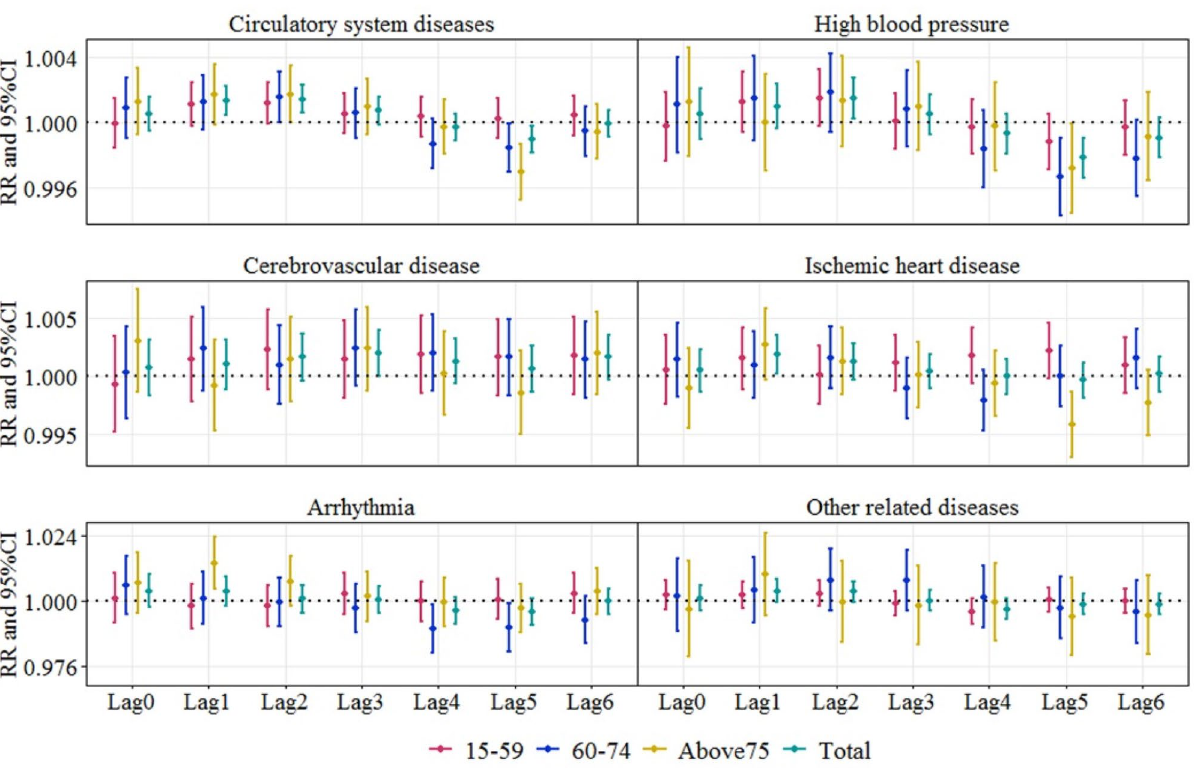
Figure 3. Relative risks s of emergency room visits for every 10 μg/m 3 increase in PM 10 under the age